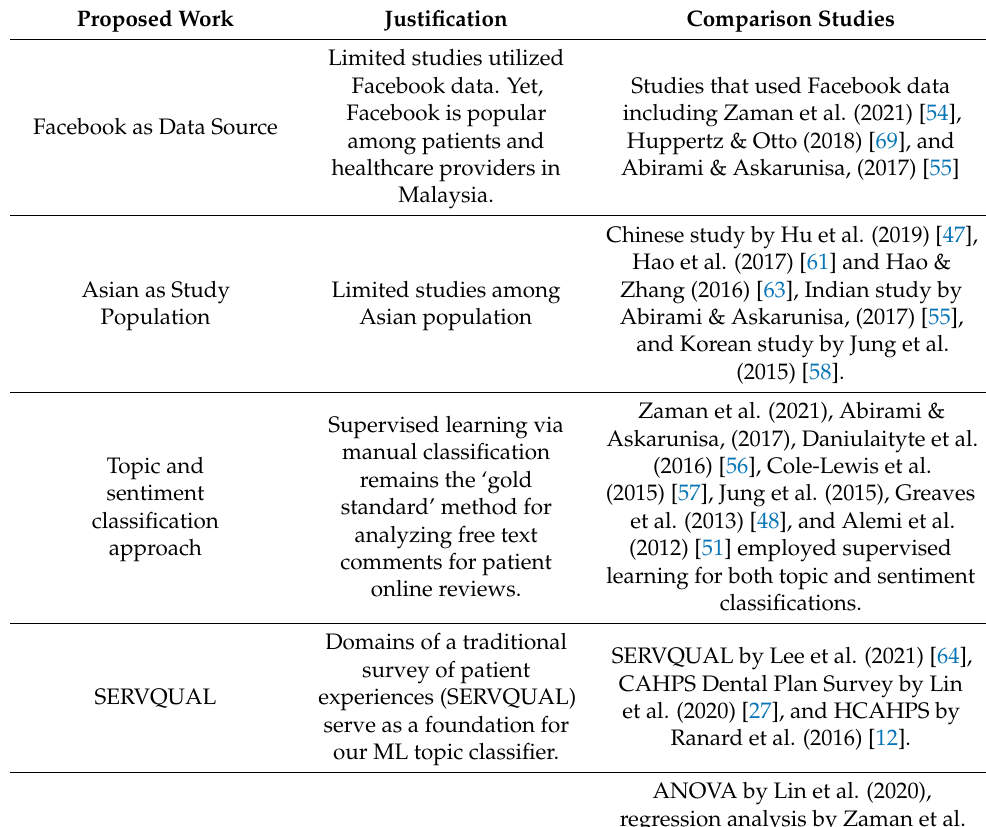
Table 2. Proposed work, its justification and comparison